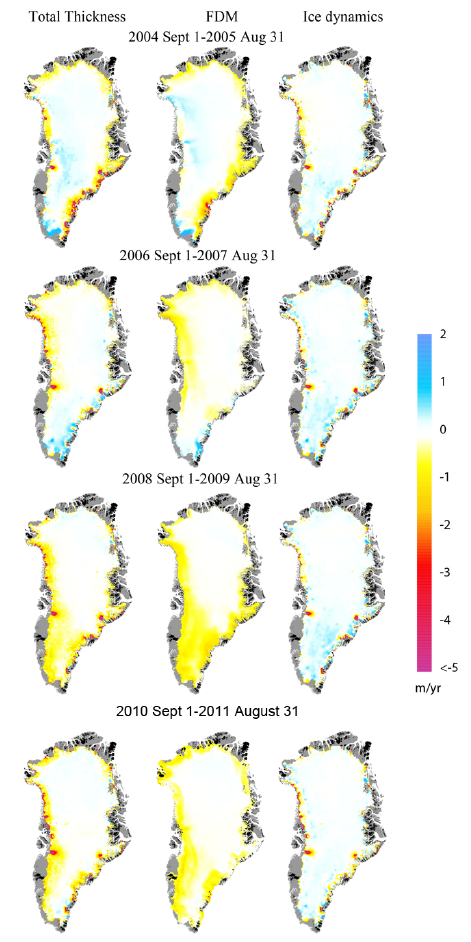
Figure 7. Annual total, FDM and ice dynamics related ice thick- ness changes in Greenland.